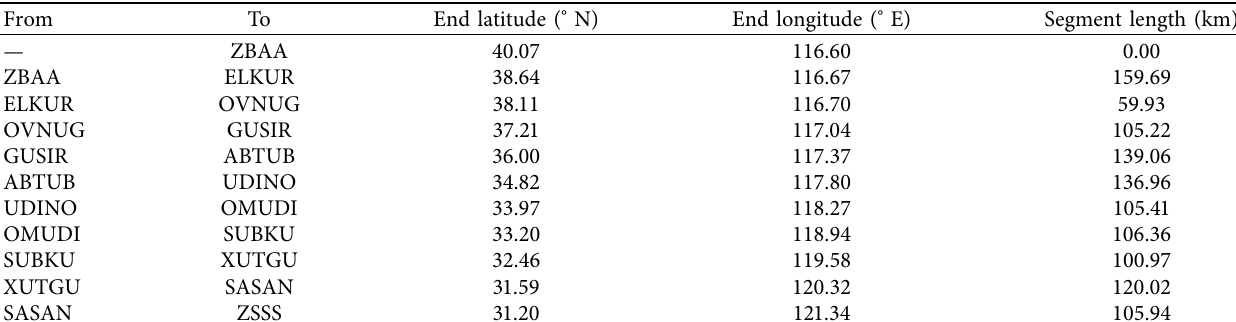
Table 1: Location information of key points on the route of